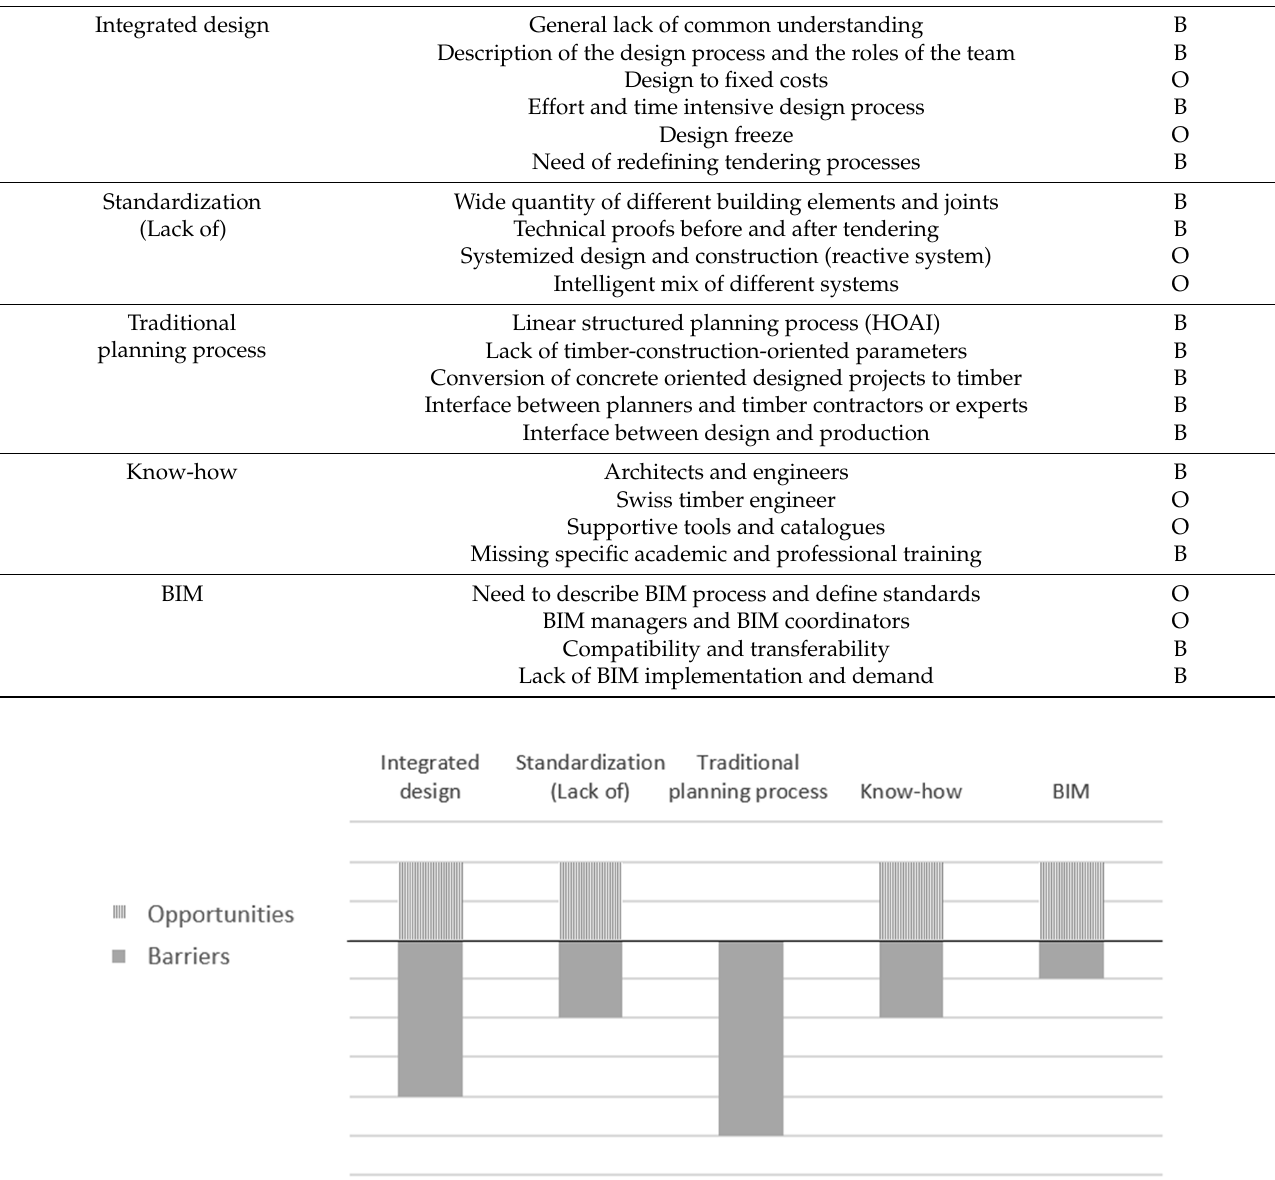
Table 5. Summary of codes in category Design with their embedded sub-codes and character accord- ing to their frequency of nomination.